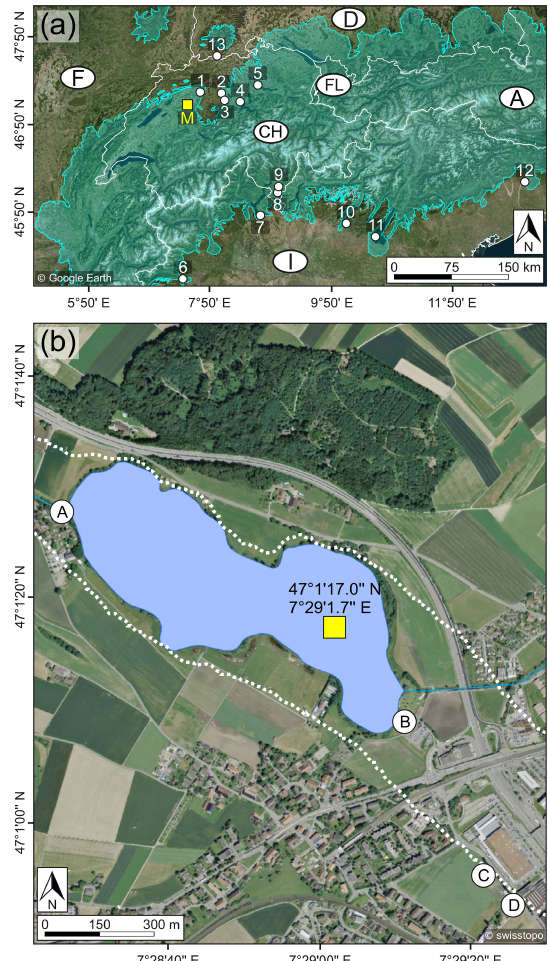
Figure 1. (a) Overview map of Switzerland (CH) and the neighboring countries (white lines: national borders; source of the satellite image: Google Earth (modified)) including the glacier extent during the Last Glacial Maximum (LGM, turquoise area; Ehlers and Gibbard, 2004), the study site Moossee (M, yellow box) and other discussed sites (white circles). 1: Burgäschisee (Rey et al., 2017); 2: Wauwilermoos (Beckmann, 2004); 3: Soppensee (Lotter, 1999); 4: Rotsee (Lotter and Zbinden, 1989); 5: Lake Zürich (Lister, 1988); 6: Lago Piccolo di Avigliana (Larocque and Finsinger, 2008); 7: Lago di Monate (this work); 8: Lago di Origlio (Tinner et al., 1999); 9: Gola di Lago (this work); 10: Lago d’Iseo (Lauterbach et al., 2012); 11: Lago di Garda (Ravazzi et al., 2014); 12: Lago di Ragogna (Monegato et al., 2007); 13: Bergsee (Duprat-Oualid et al., 2017). A: Austria; D: Germany; F: France; FL: Liechtenstein; I: Italy. (b) Detailed map of Moossee (blue area: present lake surface area; source of the aerial photograph: swisstopo (modified)), the extent of the former lake area (dotted white line; Harb, 2017), the coring coordinates (yellow box) and local archeological sites (white circles; Harb, 2017). A: Moossee West; B: Moossee East; C: Moosbühl II; D: Moosbühl